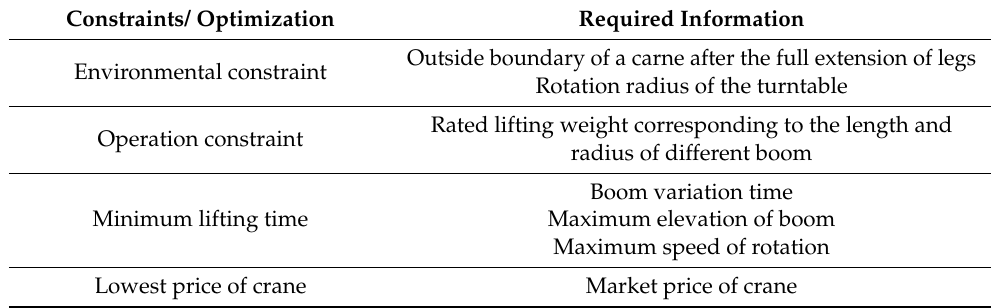
Table 3. Parameter information of a crane required for crane selection and